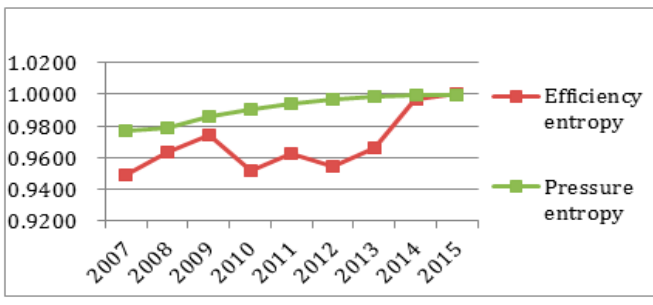
Figure 9. Entropy flow change in the social subsystem.